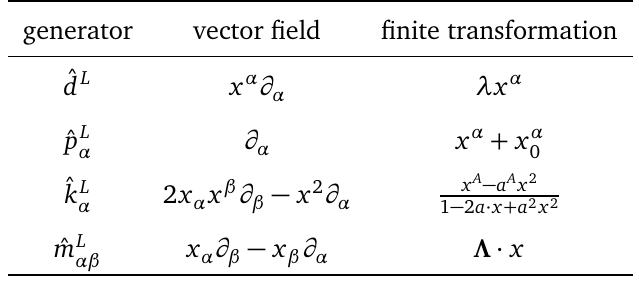
Table 5: Action of Lorentzian conformal symmetry generators as vector fields on the